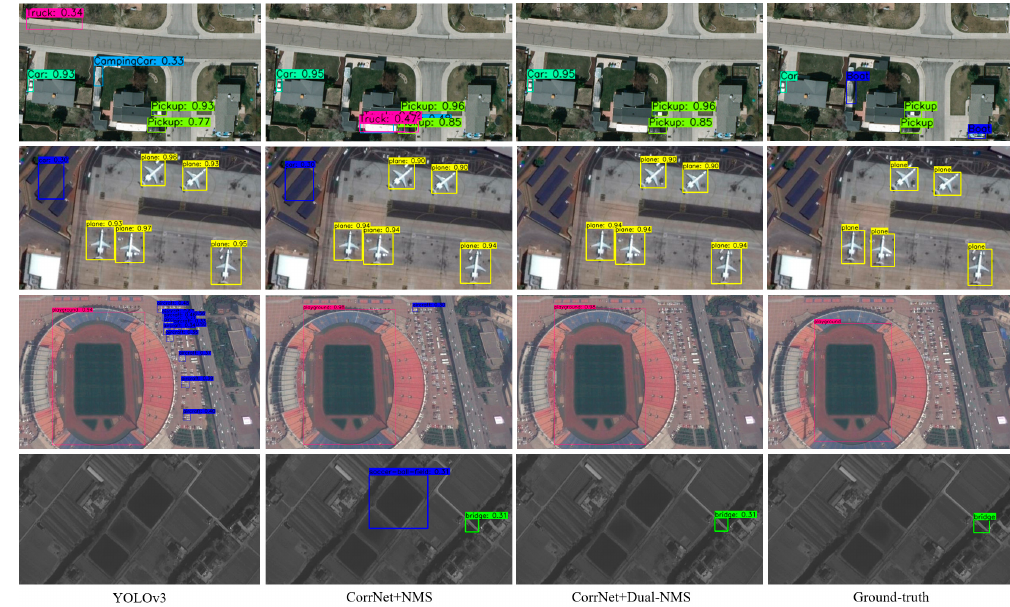
Figure 11. Comparison of the detection results of different network structures. From top to bottom, the results are for the VEDAI, UCAS-AOD, RSOD and DOTA datasets.